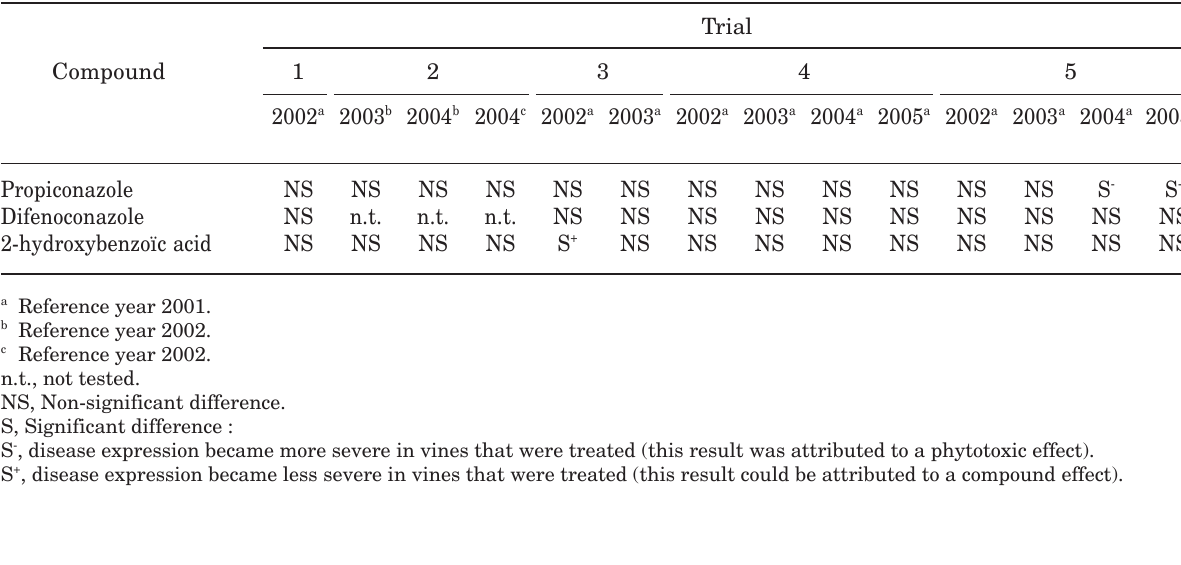
Table 4. Results of statistical χ 2 tests ( α =5%) comparing the disease evolution of treated vines with control